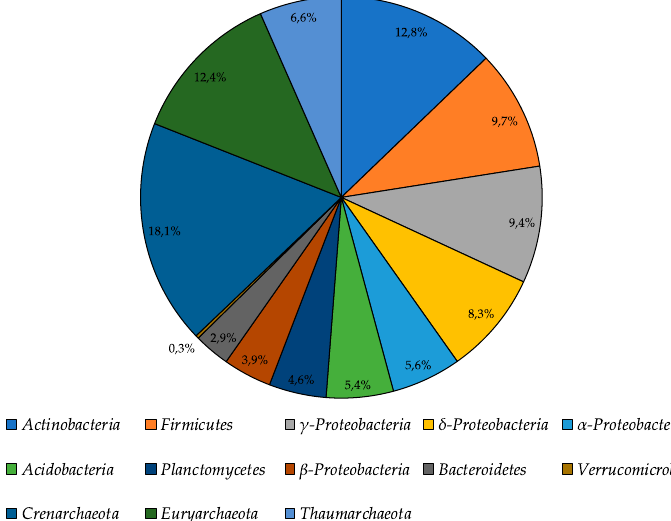
Figure 5. The structure of metabolically active prokaryotic community of moraine and ice [Nz 2] sample, obtained by fluorescence in situ hybridization analysis. Table 3. Multisubstrate testing